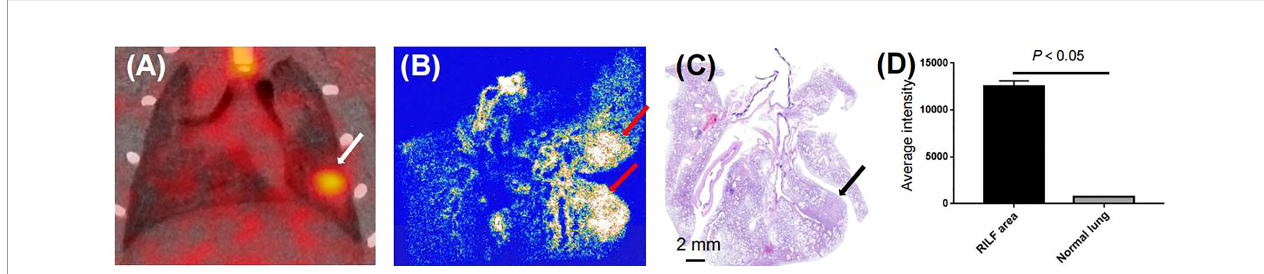
FIGURE 5 | Binding speci fi city test. (A) Serial coronal sections of PET/CT image from 60-min static scan on day 42 after radiation treatment (white arrow). (B) Autoradiographs of irradiated lungs show increased 18 F-NOTA-FAPI uptake in area of RILF at day 42 after radiation treatment (red arrow). (C) HE-stained parallel section showed acute RILF (black arrow). (D) Comparison of average intensities on autoradiographic imaging between areas of RILF and normal lung (n =